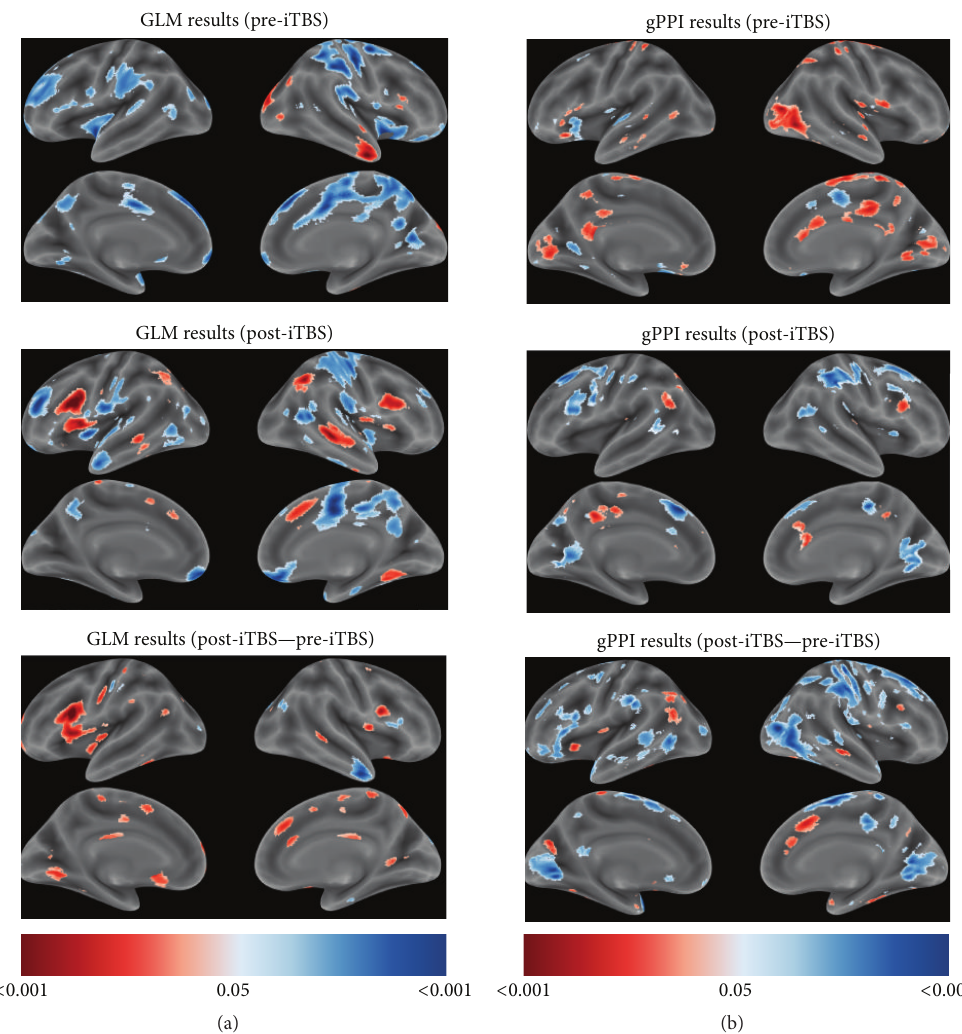
Figure 4: Whole-brain statistical maps for GLM and gPPI analyses. (a) Statistical parametric maps (SPMs) illustrating whole-brain activation for the VG > FT (red) and VG < FT (blue) contrasts from the pre-iTBS (top) and post-iTBS (middle) scan sessions are shown to illustrate overall activation patterns for each scan session (left, middle). An SPM illustrating changes in VG activation is also shown (bottom). (b) SPMs illustrating whole-brain gPPI results for the R IFG seed region for the VG > FT (red) and VG < FT (blue) contrasts from the pre-iTBS (top) and post-iTBS (bottom) scan sessions are shown to illustrate overall task-dependent connectivity patterns for each scan session. An SPM illustrating changes in task-dependent connectivity is also shown (bottom). Color bar values for all SPMs indicate uncorrected 𝑃 values ranging from 0.05 to <